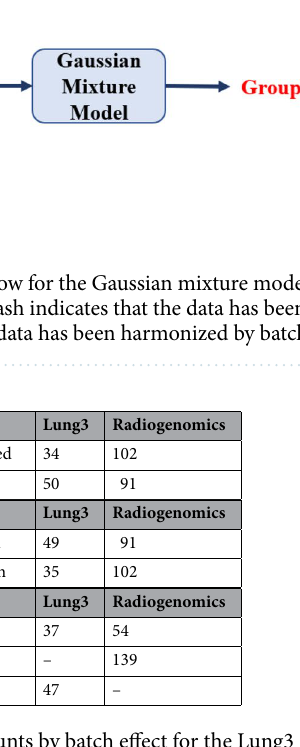
Table 4. Case counts by batch effect for the Lung3 and Radiogenomics